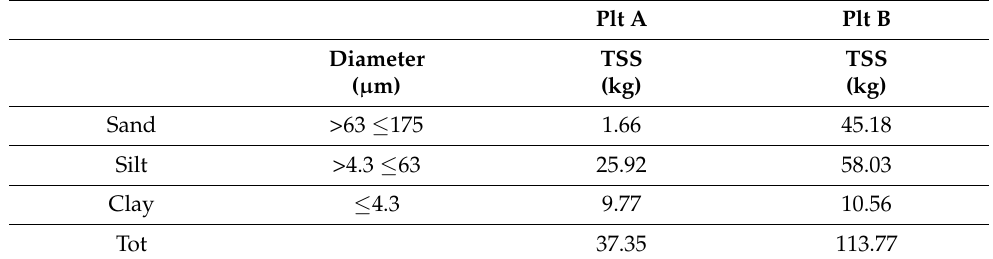
Table 5. TSS discharged with the PW during the monthly simulation for platform A and B.